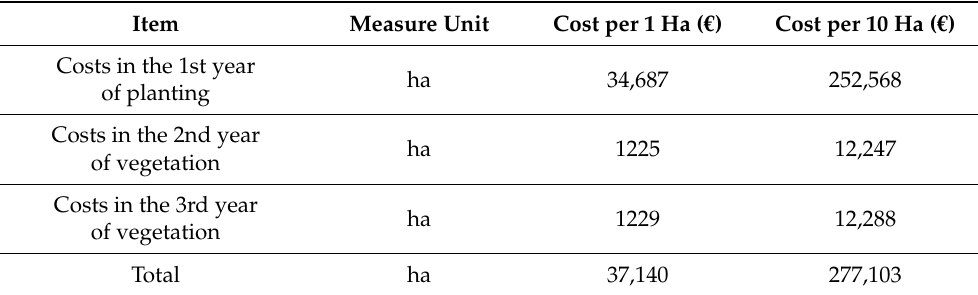
Table 1. Costs of planting and treating the Aronia melanocarpa plantation up to the first year of fertility (intensive cultivation method).